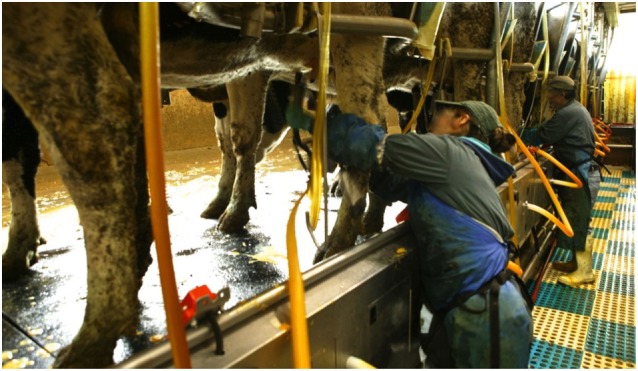
An American dairy worker attaching milking cluster to cow teats/udder.